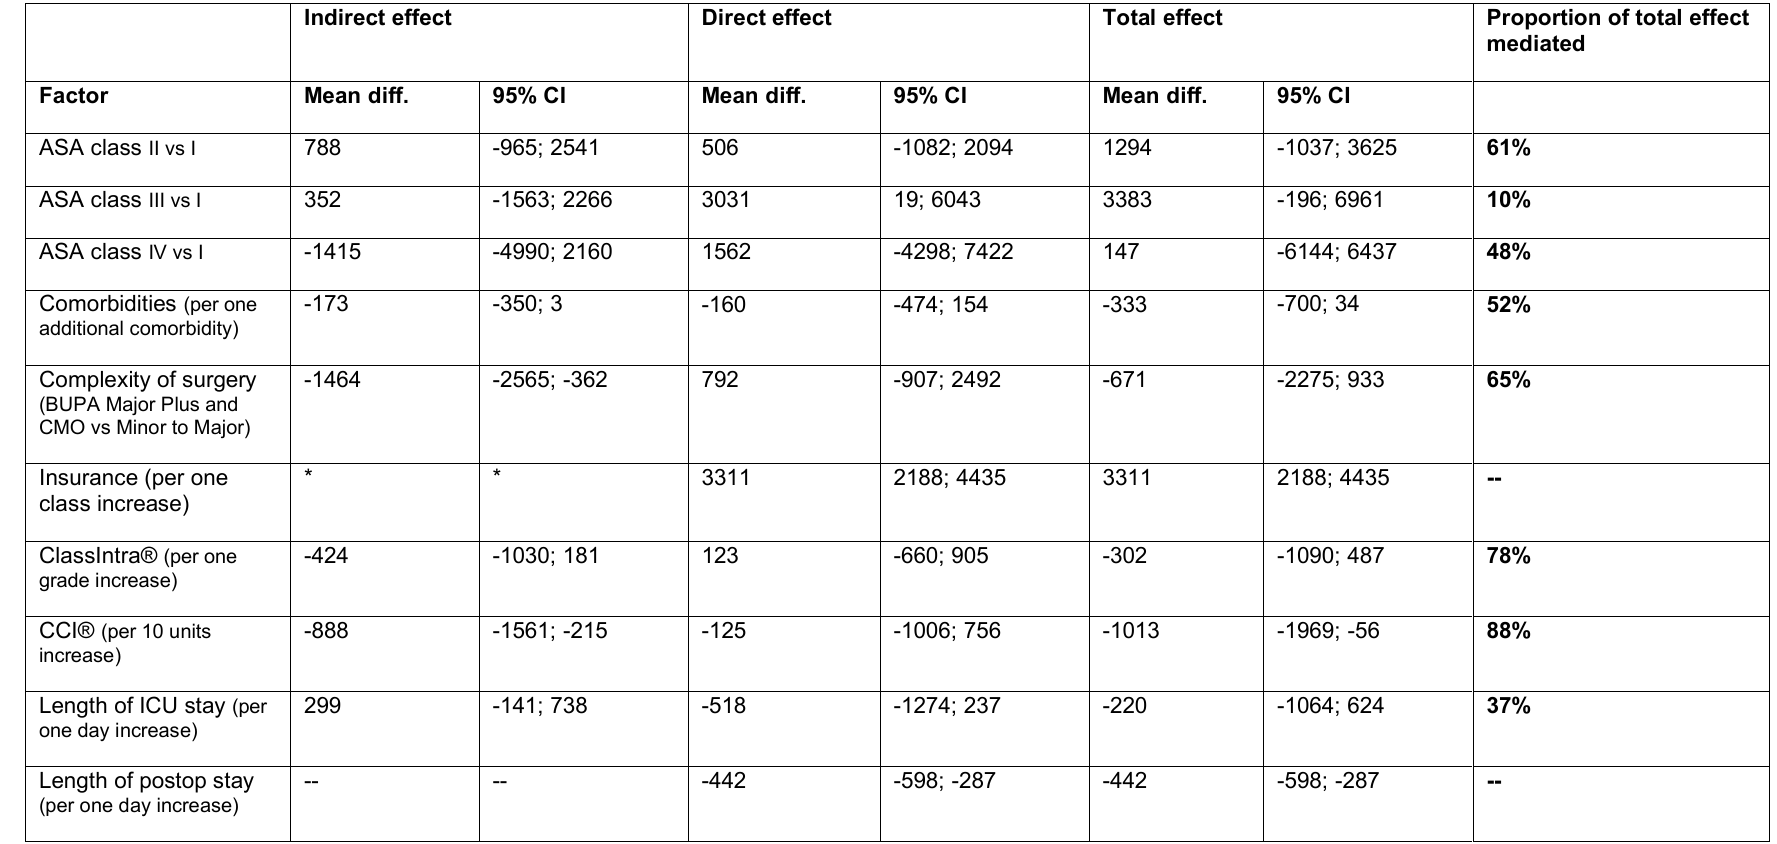
Table 11: Reimbursement model excluding recurrent patients (in Euros) Indirect, direct and total effects on reimbursement. Coefficients are mean differences in reimbursement; patients with protracted hospital or ICU stay were NOT excluded. R-squared 50.3%